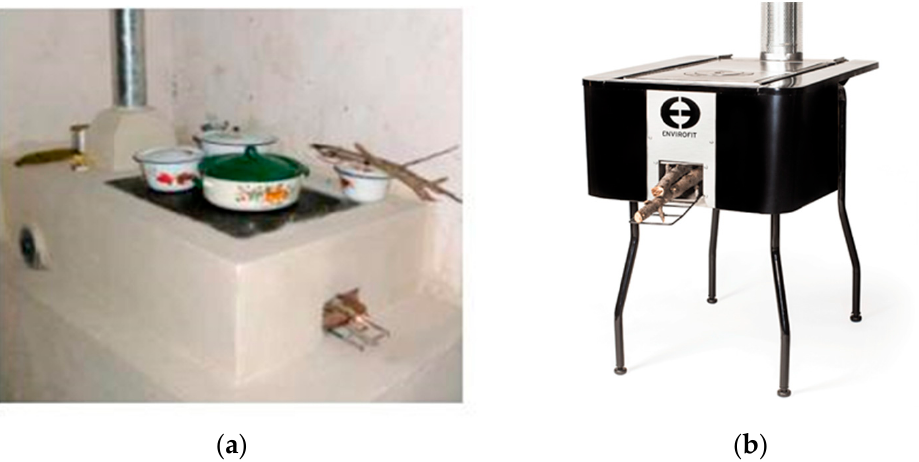
Figure 2. Traditional and improved stoves used for cooking in Honduras. (https: // envirofit.org / honduras / ). ( a ) Traditional firewood stove ( b ) Improved